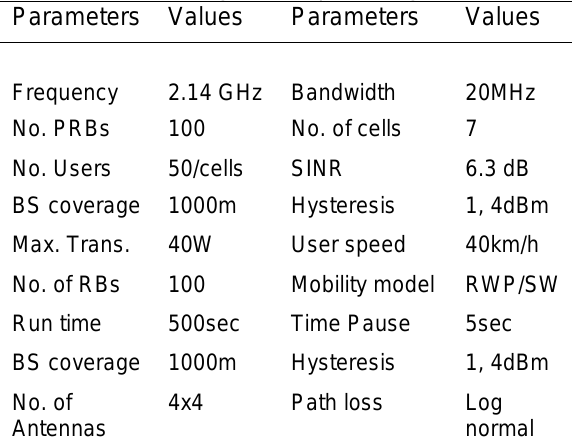
Figure 5. Breakdown of BS power consumption